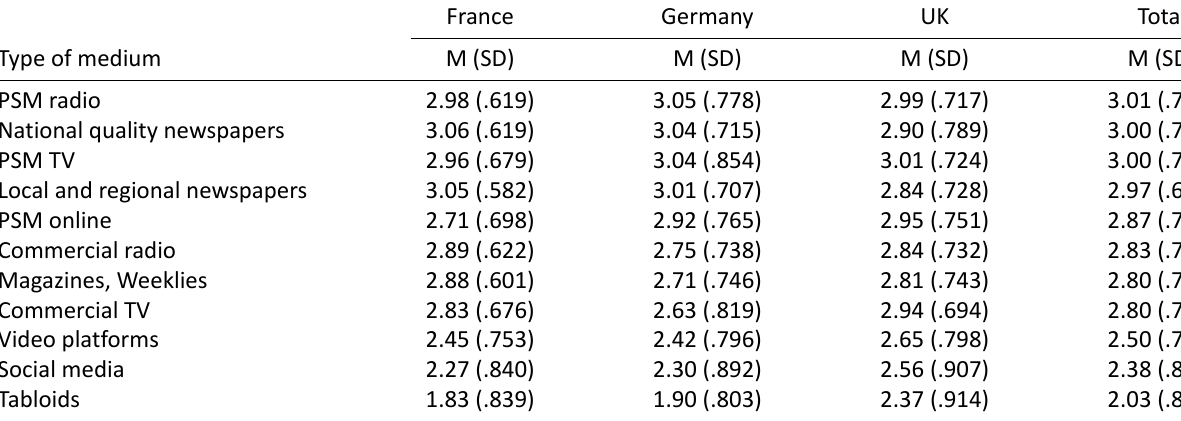
Table 2. Assessment of information quality of various types of media in France, Germany, and the UK. France